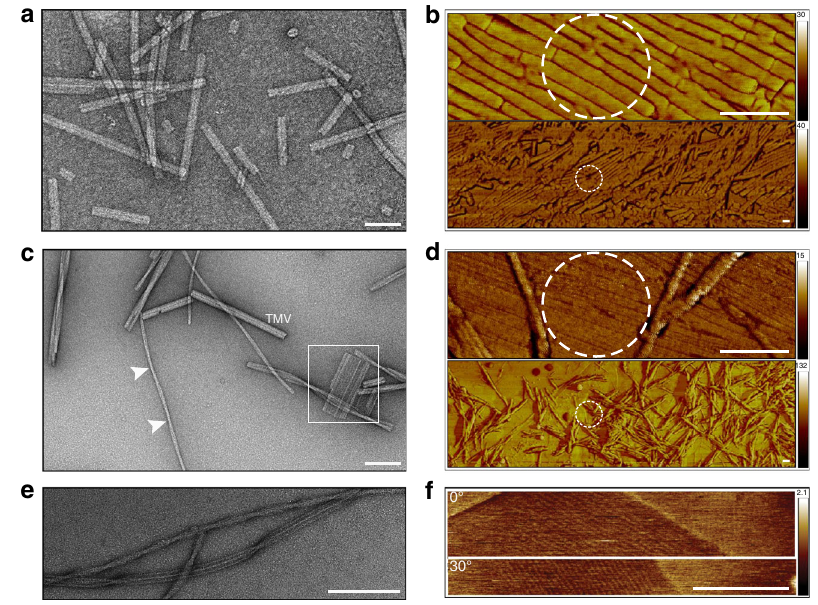
Fig. 2 Preparation of TMV fi laments and amyloid proto fi brils on graphene. a , b Representative negative-stain TEM and AFM images of TMV, c – d bombesin fi laments, and e , f β -endorphin fi laments are shown. Negative-stain images ( a , c , e ) were acquired on fi brils placed on amorphous carbon fi lms and AFM images ( b , d , f ) on graphene. Scalebars are 100 nm. b TMV fi brils align naturally on graphene over hundreds of nanometers. However, on the micrometer scale, aligned and randomly ordered fi brils are co-present. c Bombesin proto fi brils associate laterally to form fi bers, which randomly twist. A single preparation may consist of different polymorphs, e.g., twisted fi bers and fi bril rafts which are depicted here with arrows and squares, respectively. Bombesin fi bers were mixed with TMV to compare their thickness. d The alignment of bombesin proto fi brils on graphene is shown. Mature fi bers are detected at larger magni fi cations. e β – endorphin proto fi brils associate laterally to form twisted and striated fi bers. f Aligned β – endorphin proto fi brils were observed on graphene supports. To con fi rm that the features that are being imaged by the AFM are from the sample and not an artifact caused by the probe, the sample was rotated by 30 ° with respect to the scanning direction. Dashed circles represent the XFEL focus with FWHM = 150 Frames showing diffraction from graphene-covered sample- free holes were selected from a series of 4352 detector frames with diluted TMV. The selection criteria are described in Supplemen- tary Fig. 5 and Methods. The average background from sample- free holes contains about 119,556 scattered photons (Fig. 3a,